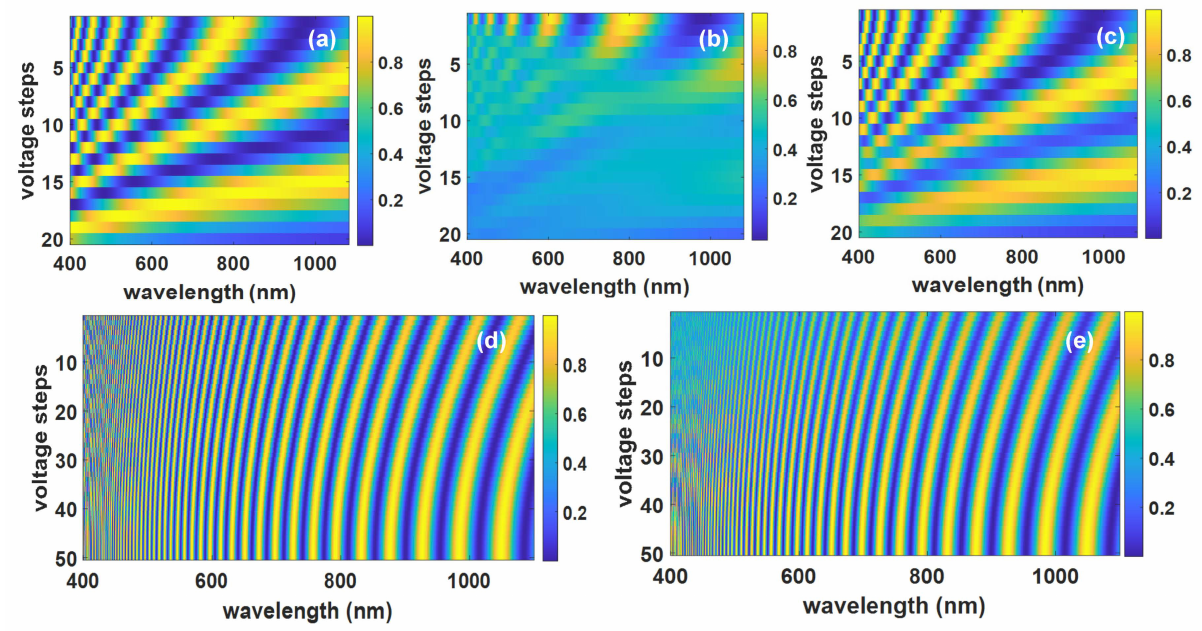
Figure 16. Simulated transmission matrix for different incidence angles: ( a ) NLC E7 at 0 deg; ( b ) is the averaged modulation of anti-parallel NLC E7 at 20 ◦ light-cone; ( c ) is the averaged modulation parallel NLC at 20 ◦ light-cone; ( d ) is the DHF FLC-618 at 0 deg; ( e ) is the averaged modulation of DHFLC at 20 ◦